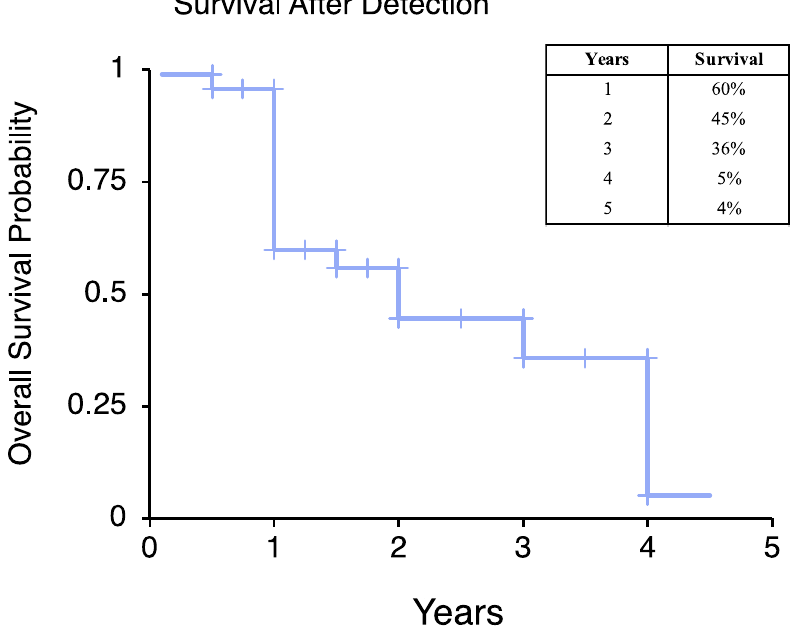
Figure 3. Kaplan–Meier analysis of overall survival after detection of metastatic disease.